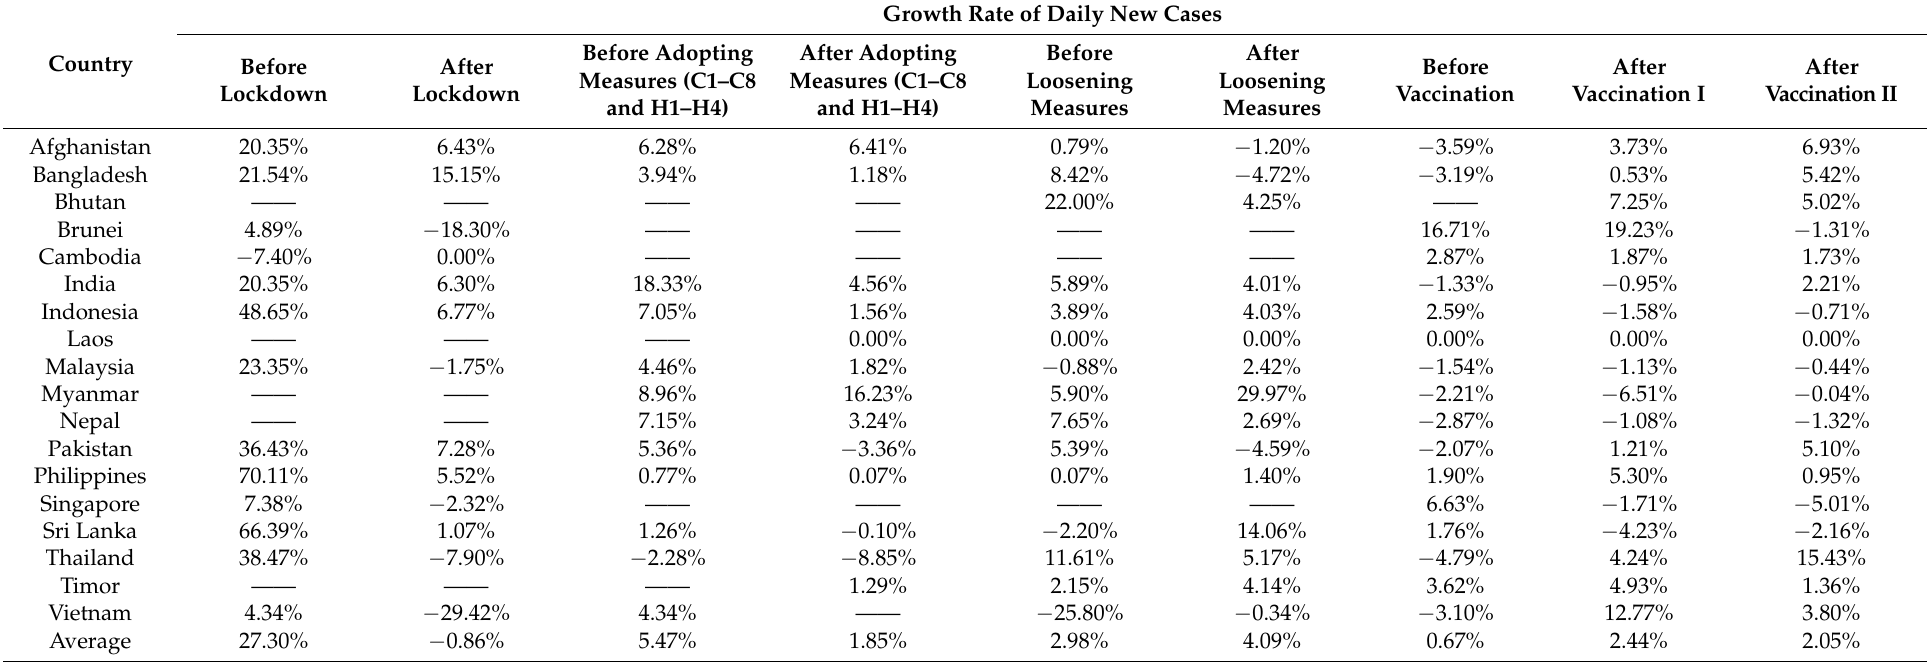
Table 2. Growth rate of daily new cases before and after intervention measures (except for Maldives due to data